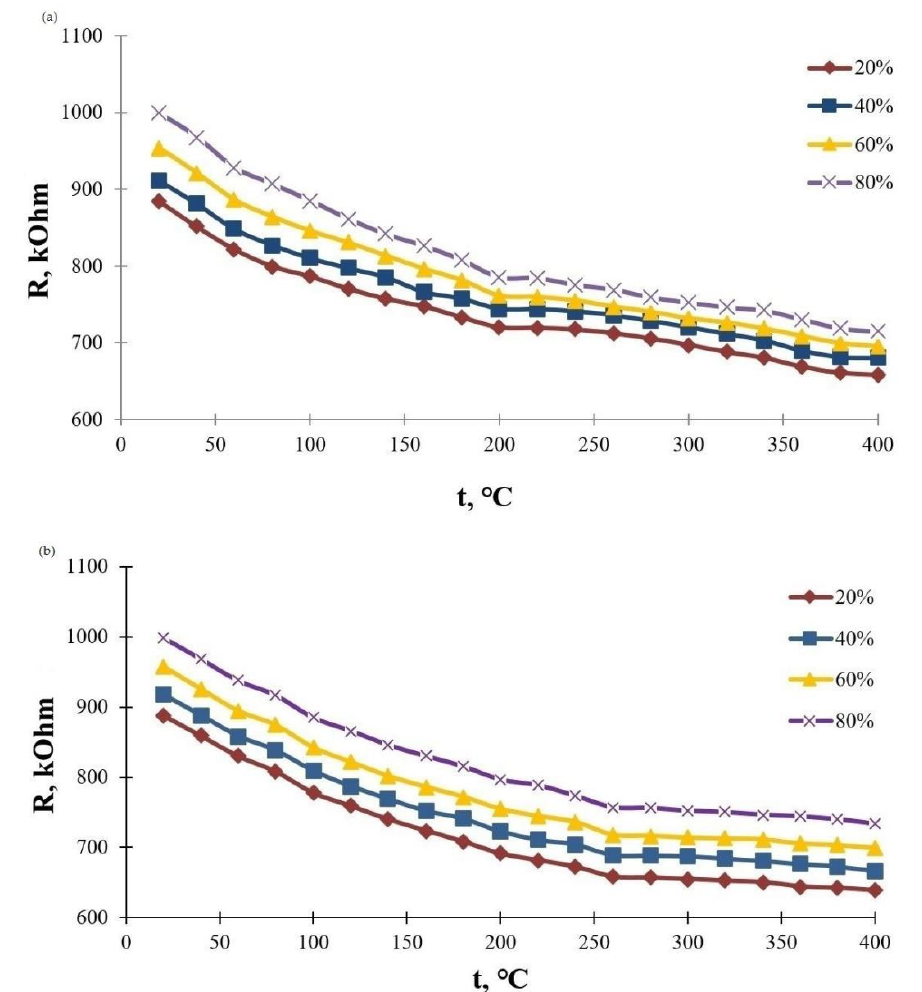
Figure 4. Temperature dependence of the specific surface resistance of thin films obtained on the GaAs surface under the influence of various compositions Y 2 O 3 + Sb 2 O 3 in the presence of ( a ) CO, ( b ) NH 3 .